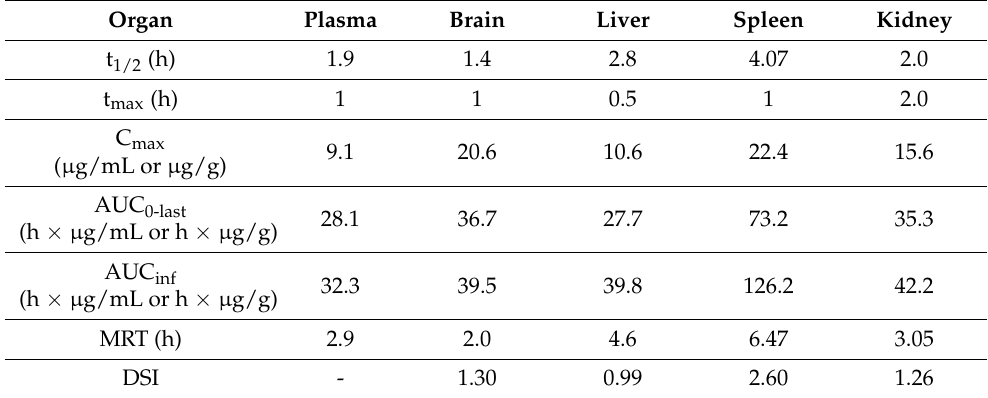
AUC 0-last (h × µ g/mL or h × µ